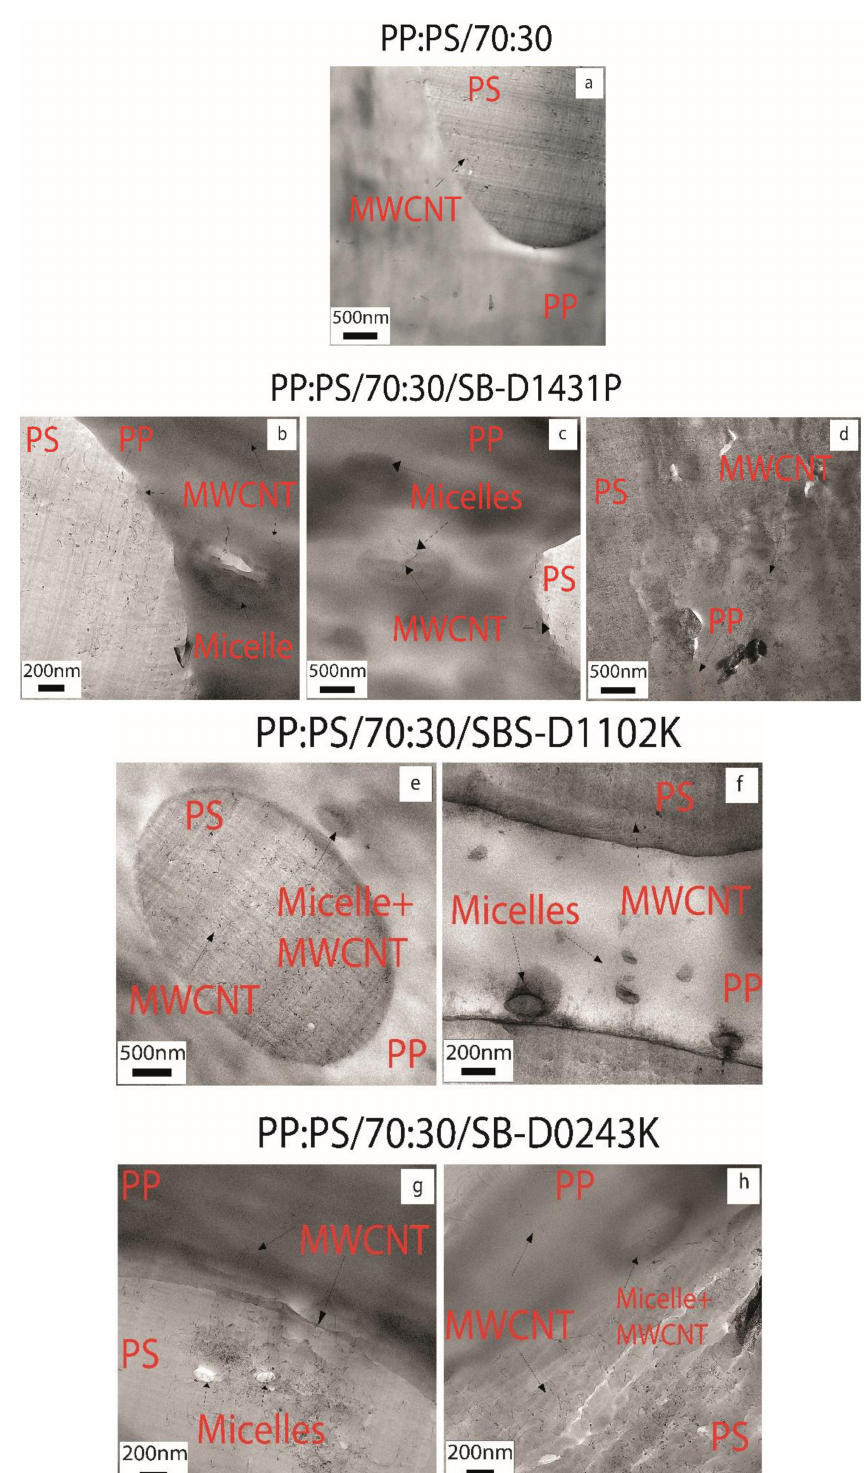
Figure 4. TEM micrographs of 1.0 vol.% multi-walled carbon nanotubes (MWCNT) and 5 vol.% copolymer filled ( a ) PP:PS/70:30, ( b – d ) PP:PS/70:30/SB-D1431P, ( e , f ) PP:PS/70:30/SBS-D1102K, and ( g , h ) PP:PS/70:30/SB-D0243K